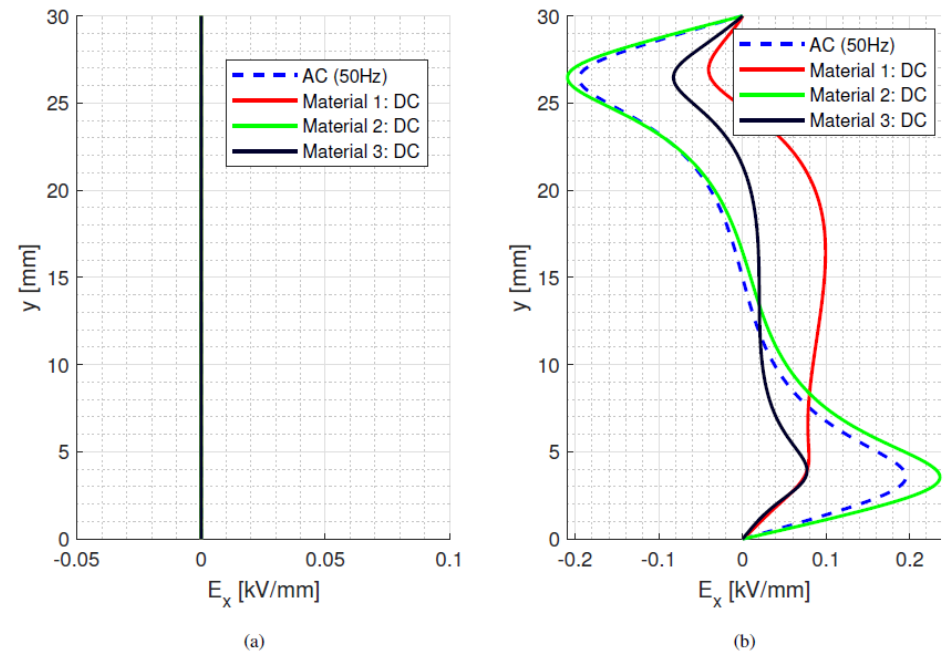
Figure 10. ( a ) Radial bulk and ( b ) orthogonal surface field (Ex) for ac and dc steady state, with a temperature gradient of 20 °C (high-potential electrode warm, Figure 1a). Material characteristics of Table 2.